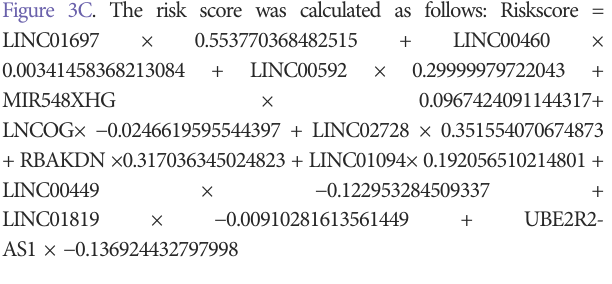
Figure 3C. The risk score was calculated as follows: Riskscore = LINC01697